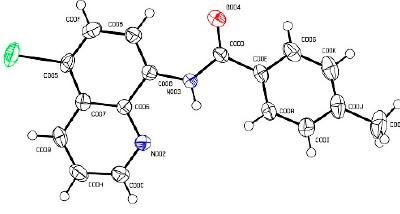
Figure 1. Single-crystal X-ray structure of 2l .